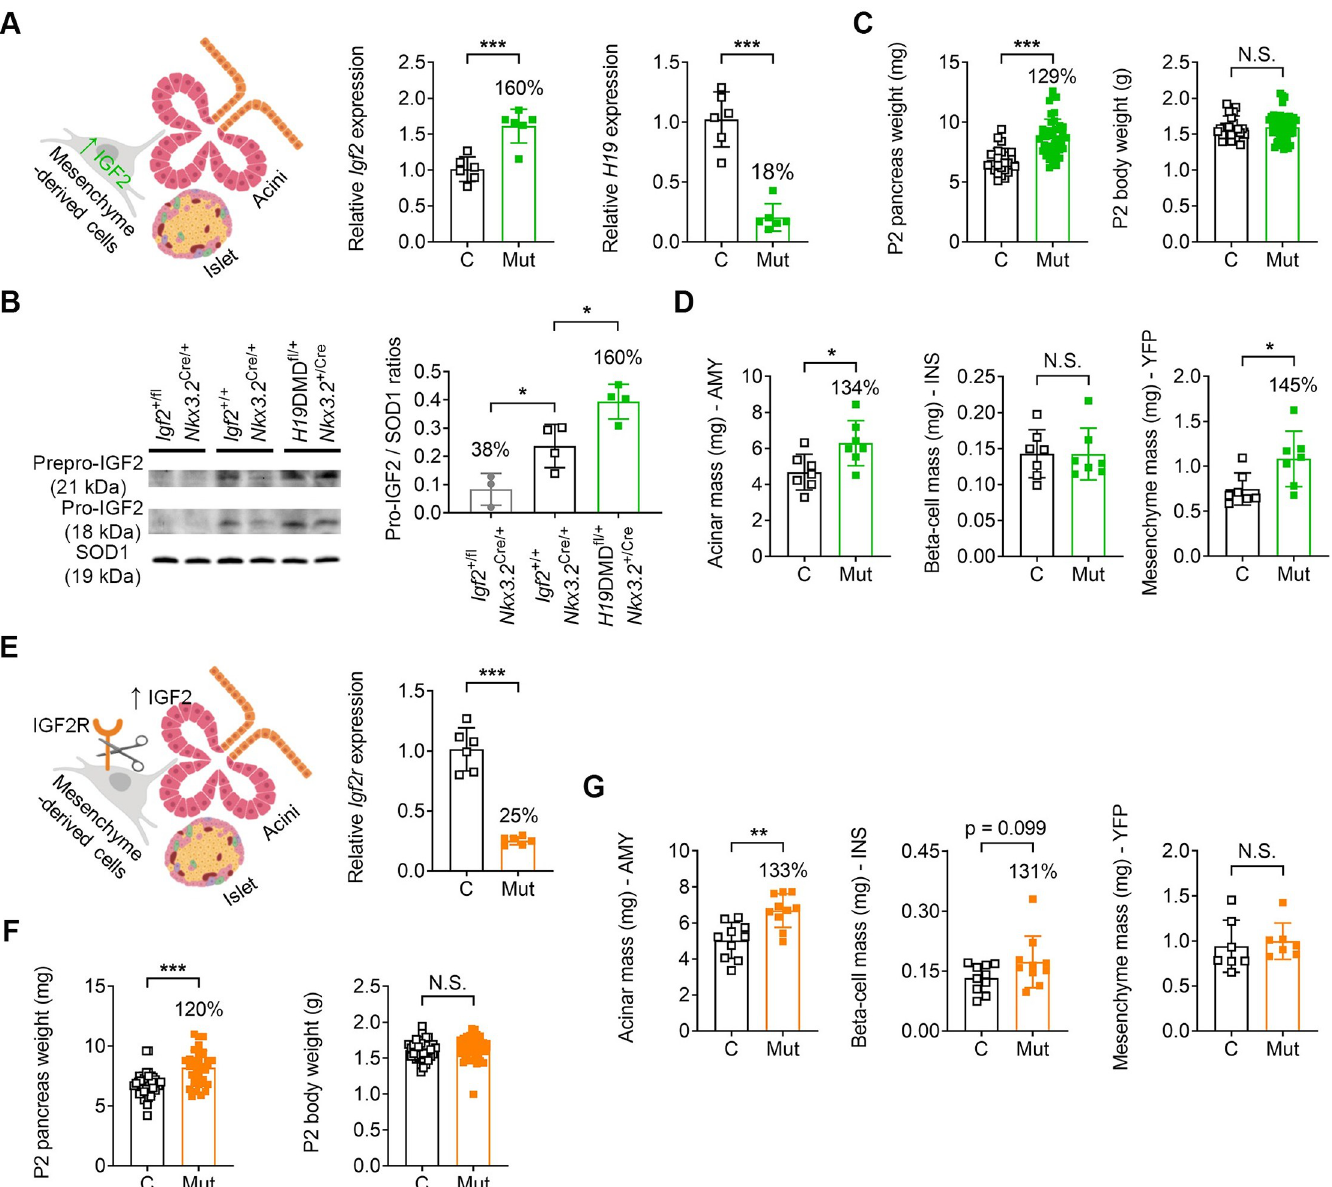
Fig 4. Impact of mesenchyme-specific Igf2 gain-of-function on pancreas at postnatal day 2 (P2). (A) Left: schematic representation of conditional Igf2 overexpression in pancreatic mesenchyme. Right: increased Igf2 mRNA expression and reduced H19 RNA levels in whole pancreases of mutant mice (Mut: H19 DMD fl/ + ; Rosa26YFP -stop fl/+ ; Nkx3 . 2 +/Cre ) compared to control littermates (C: H19 DMD +/+ ; Rosa26YFP -stop fl/+ ) measured by qRT-PCR (normalized to Ppia and shown relative to levels in controls). (B) Left: western blot analysis of Prepro-IGF2 and Pro-IGF2 in the two models of Igf2 loss-of-function and Igf2 gain-of-function. Right: quantification graph for Pro-IGF2/SOD1 ratios only. (C) Pancreas weights are significantly increased in mutants with conditional Igf2 overexpression in the mesenchyme (Mut: H19 DMD fl/+ ; Rosa26YFP -stop fl/+ ; Nkx3 . 2 +/Cre ), compared to littermate controls (C: H19 DMD +/+ ; Rosa26YFP -stop fl/+ ). Body weights are similar between genotypes. (D) Stereological measurements show a significant increase in acinar mass and mesenchyme mass, but not in beta-cell mass in mutants with conditional Igf2 overexpression in the mesenchyme (Mut: H19 DMD fl/+ ; Rosa26YFP -stop fl/+ ; Nkx3 . 2 +/Cre ), compared to littermate controls (C: H19 DMD +/+ ; Rosa26YFP -stop fl/+ ; Nkx3 . 2 +/Cre ). (E) Left: schematic representation of conditional Igf2r deletion in pancreatic mesenchyme. Right: reduced Igf2r mRNA levels in whole pancreases of mutant mice (Mut: Igf2r fl/+ ; Rosa26YFP -stop fl/+ ; Nkx3 . 2 +/Cre ) compared to control littermates (C: Igf2r +/+ ; Rosa26YFP -stop fl/+ ) measured by qRT-PCR. Data was normalized to Ppia and is shown relative to levels in controls (arbitrarily set to 1). (F) Pancreas weights are significantly increased in mutants with conditional Igf2r deletion in the mesenchyme (Mut: Igf2r fl/+ ; Rosa26YFP -stop fl/+ ; Nkx3 . 2 +/Cre ), compared to littermate controls (C: Igf2r +/+ ; Rosa26YFP -stop fl/+ ). Body weights are similar between genotypes. (G) Stereological measurements show a significant increase in acinar mass and a trend for increased beta-cell mass (P = 0.099), but similar mesenchymal mass in mutants with conditional Igf2r deletion in the mesenchyme (C: Igf2r +/+ ; Rosa26YFP -stop fl/+ ; Mut: Igf2r fl/+ ; Rosa26YFP -stop fl/+ ; Nkx3 . 2 +/Cre ). For all graphs, data is shown as individual values and averages ± SD; N.S.–non-significant, � p < 0.05, �� p < 0.01 and ��� p < 0.001 by unpaired Student’s t tests [panels (A), (C), (D), (E), (F) and (G)] or 1-way ANOVA followed by Dunnett’s post hoc test for multiple comparisons against the Igf2 +/+ ; Nkx3 . 2 Cre/+ controls [panel (B)].